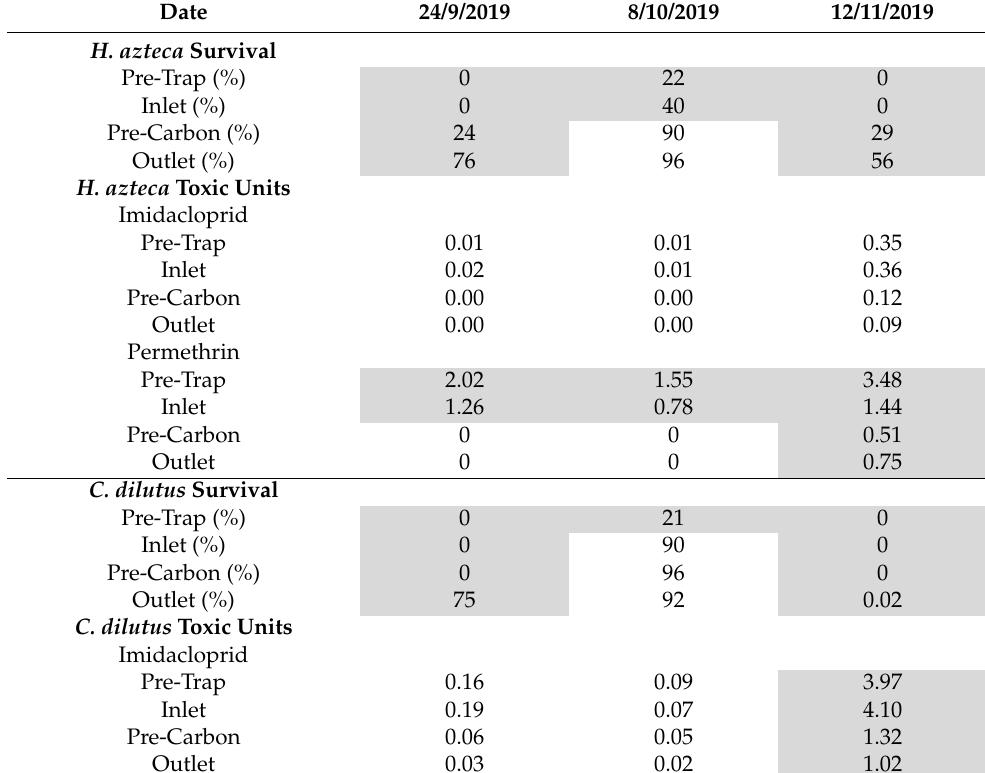
Table 4. Results of toxicity tests and related imidacloprid and permethrin toxic unit values based on insecticide concentrations measured during lettuce field runoff events. Shaded cells indicate significant toxicity or toxic unit values greater than